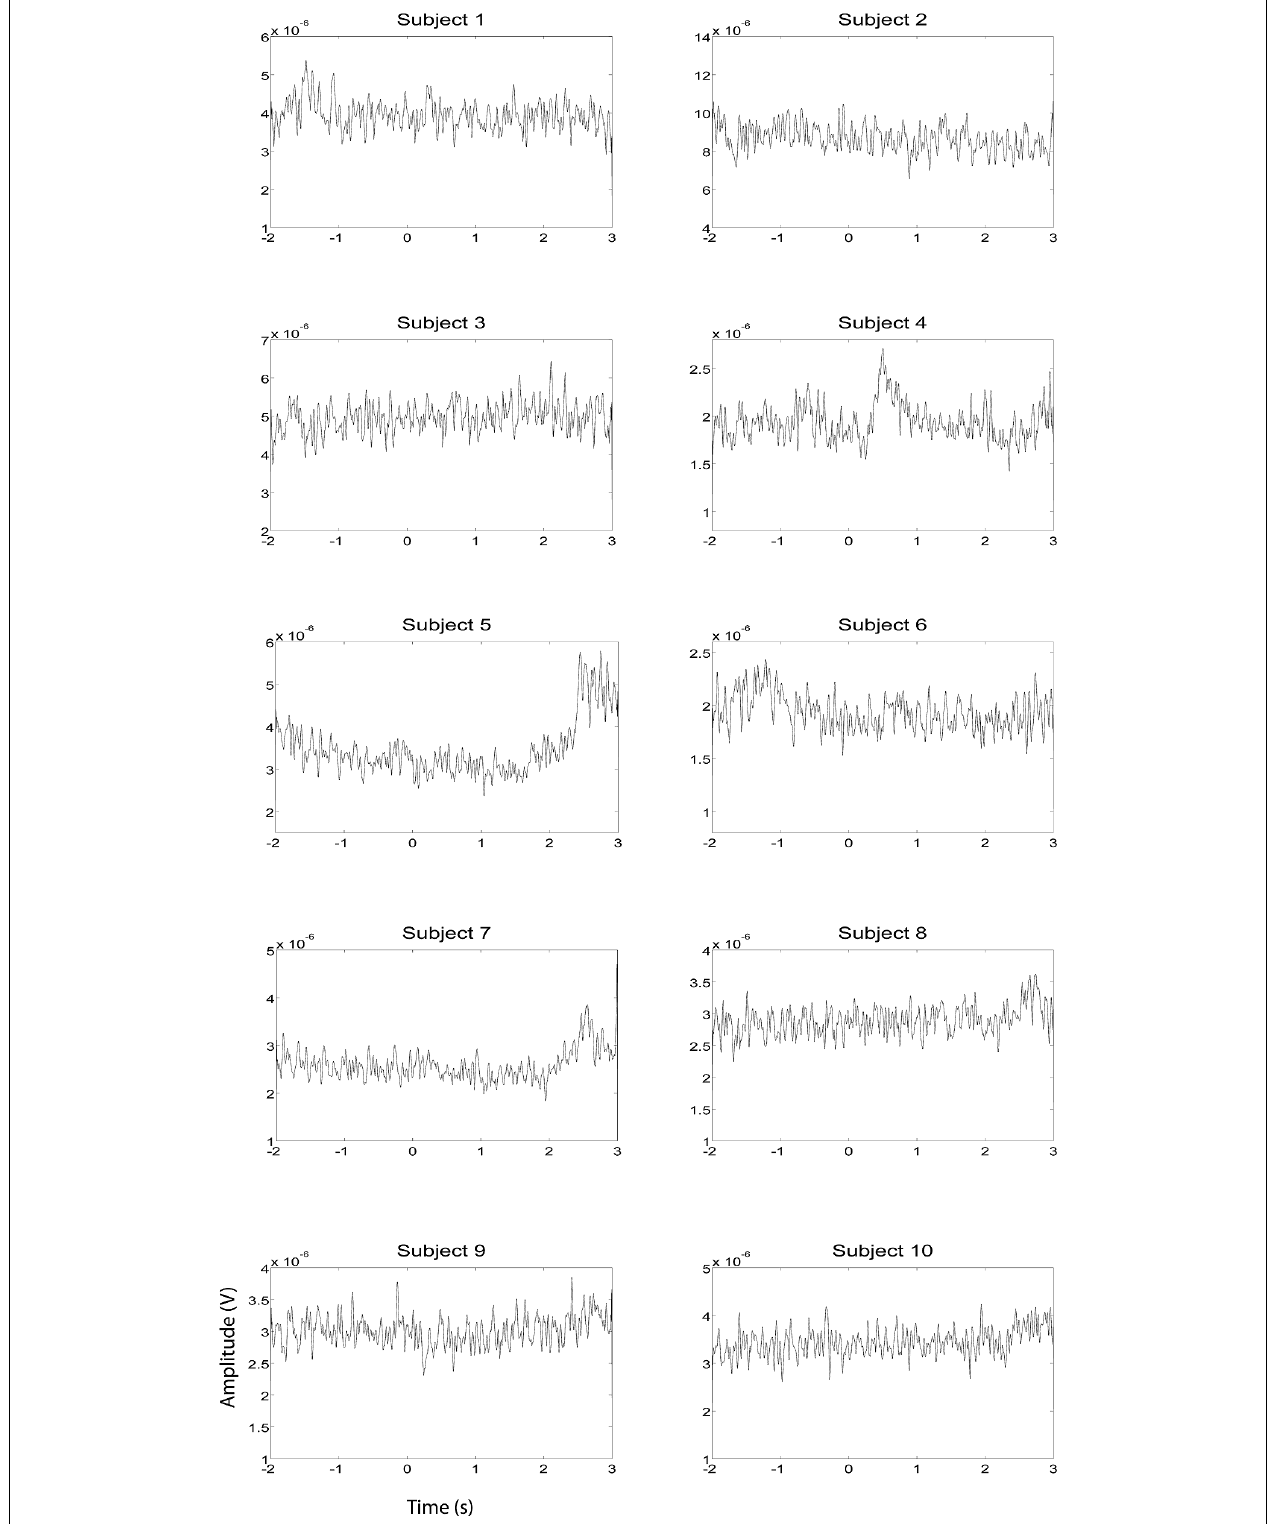
FIGURE 3 | EMG HG magnitude of the right hand during right hand motor imagery EEG recording sessions ( n = 10). EMG activity was averaged between all trials that were not contaminated by artifacts. Units of the EMG are